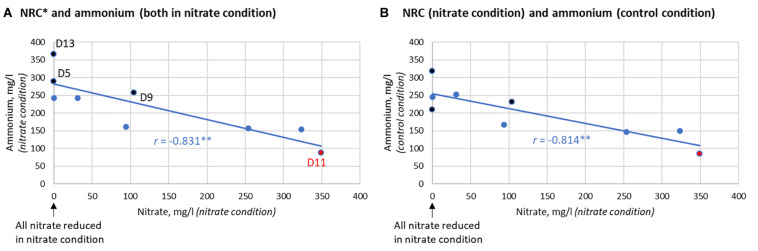
Correlation between nitrate reduction capacity (NRC) and ammonium production after 7 h. (A) Correlation between the nitrate reduction capacity (NRC), as determined by how much nitrate is left after incubation, and the ammonium detected in the nitrate condition (R = –0.831, p < 0.01). (B) Correlation between NRC and the ammonium produced in the control condition (R = –0.814, p < 0.01). This correlation indicates that the bacterial communities of donors that reduce nitrate efficiently are also capable of producing more ammonium in the absence of nitrate. The three donors that clearly produced more ammonium in the nitrate condition compared to the control condition are marked in black (from most to least extra ammonium production: D5 > D13 > D9). D5 and D13 were also two out of the three donors that reduced 100% of nitrate after 7 h. D11 had little to no nitrate reduction activity (marked in red).